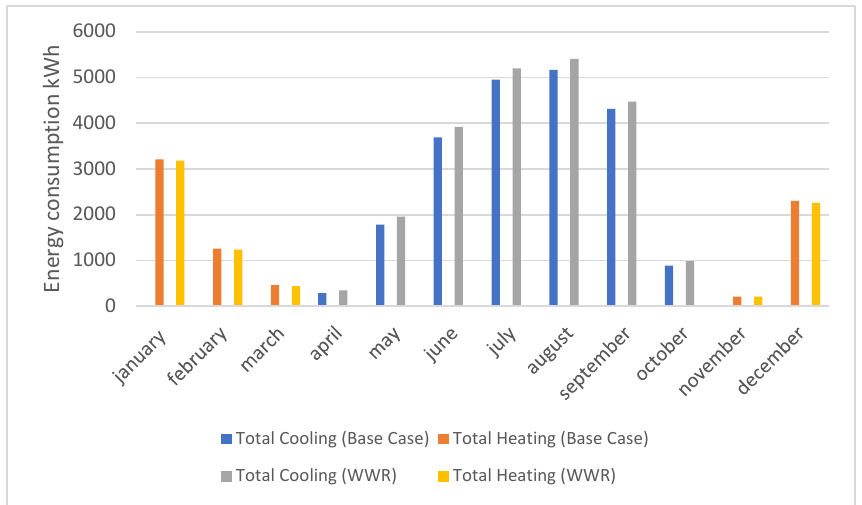
Figure 16. The annual energy consumption for Case 2 with modifying the WWR to adapt the contemporary house characteristics.